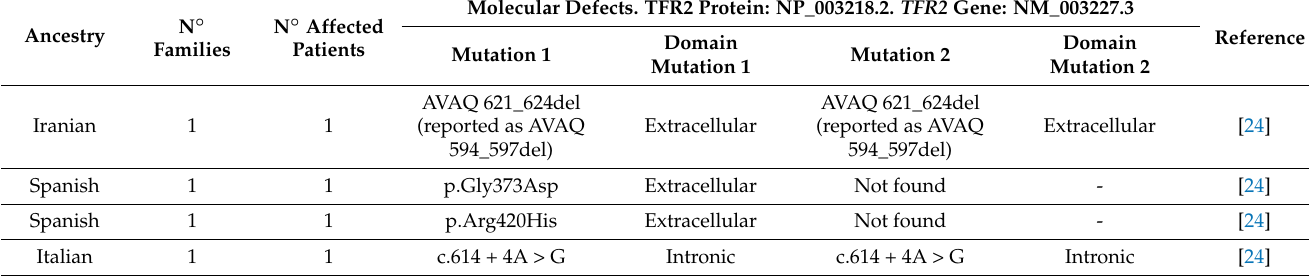
Table A2. List of patients diagnosed with non-HFE related HH with mutations in the TFR2 gene. The domain localiza- tion of the mutations is described according to Figure 3